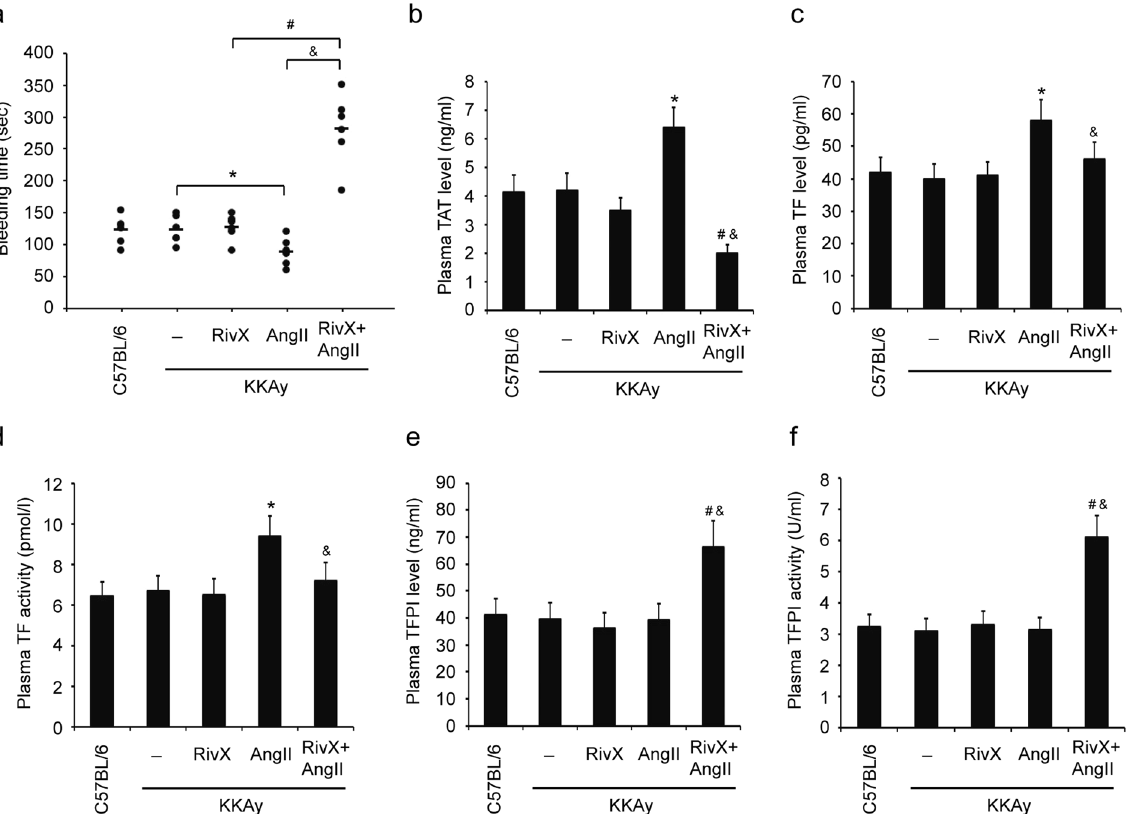
Figure 1. AngII promoted the anticoagulant effects of rivaroxaban in KKAy mice. Mice were administered orally with rivaroxaban (RivX, 5 mg/kg body weight/day), or infused with AngII (1,500 ng/kg/min), or co- treated with RivX and AngII for 2 weeks. ( a ) Under isoflurane anesthesis, bleeding time was assessed. Blood was collected by cardiac puncture to determine the plasma levels of thrombin-antithrombin (TAT) complex ( b ), tissue factor (TF) ( c ), and TF pathway inhibitor (TFPI) ( d ), as well as the plasma activities of TF ( e ) and TFPI ( f ). The bars show the mean ± SEM (n = 6 to 8). * P < 0.05, compared with the KKAy blank group; # P < 0.05, compared with the RivX treatment group; & P < 0.05, compared with the AngII treatment